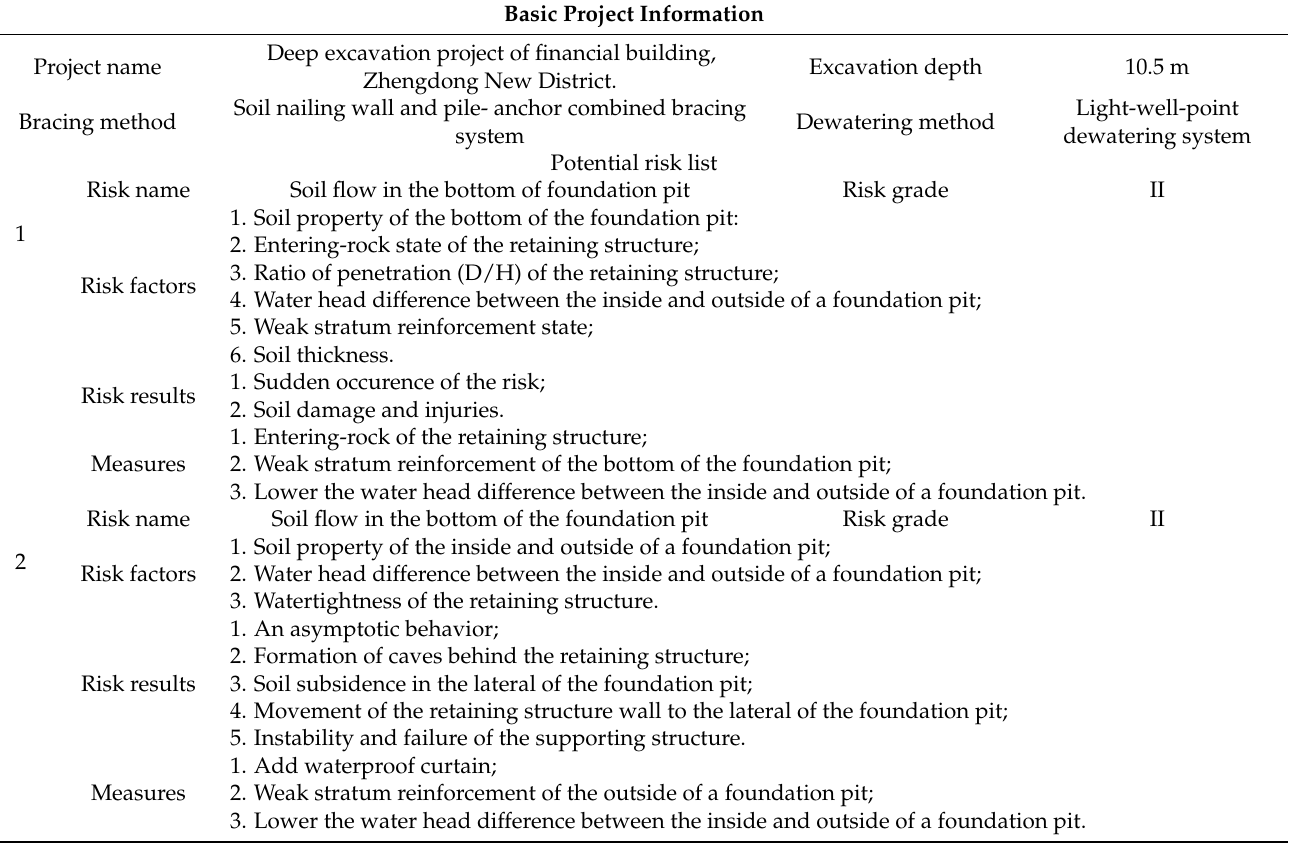
Table 5. Manual safety risk identification results and associated suggestions